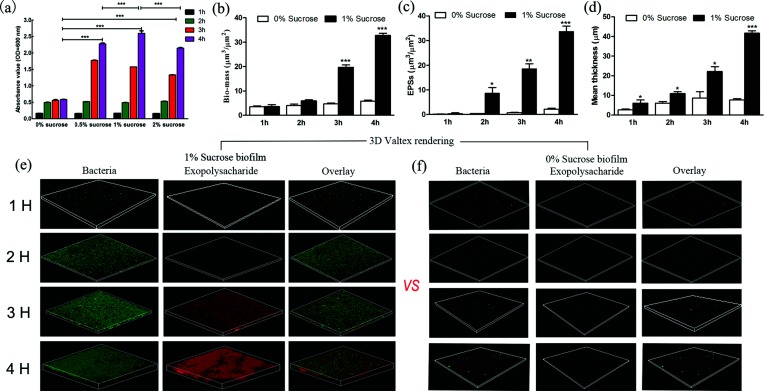
Effects of sucrose on S. mutans adhesion. (a) A crystalline violet staining experiment was performed to determine the S. mutans adhesion under different sucrose concentrations and at different time points. (b) The bio-volume and (c) mean thickness of biofilms were both calculated. (d) Representative three-dimensional images of bacteria in the biofilms. (e) Representative three-dimensional images of EPS production and distribution in the biofilm architecture. Images were magnified 20-fold. The error bars represent the standard deviations. *, significant difference at P<0.05; **, P<0.01; ***, P<0.001.